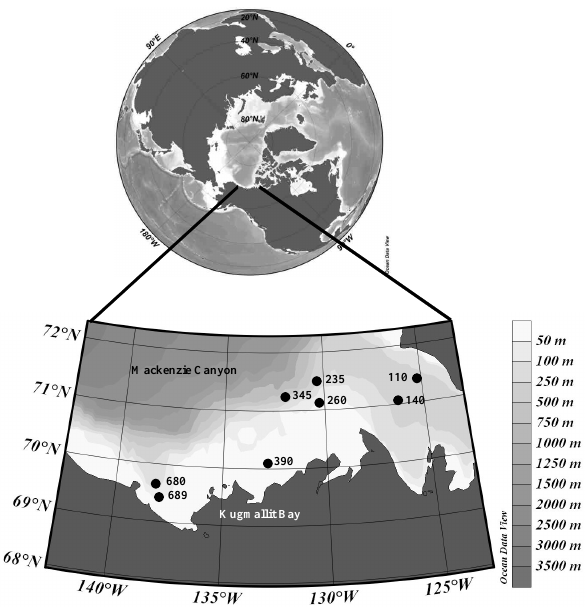
Fig. 1. Map of the studied area with locations of the different sta- tions